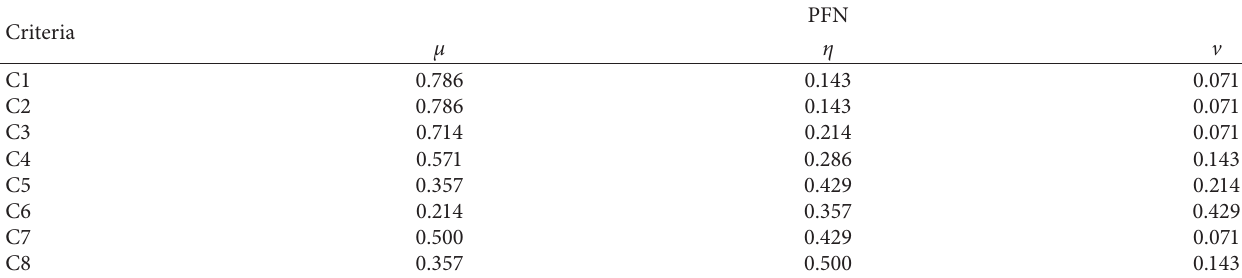
Table 6: Criteria rating matrix in terms of PFNs (calculated by aggregating responses on linguistic scales). Criteria